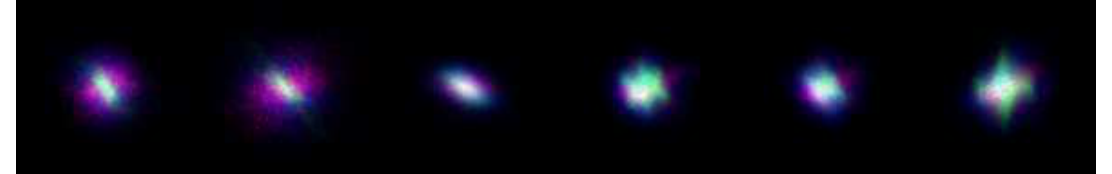
Figure 6. Images of normal data under various conditions.